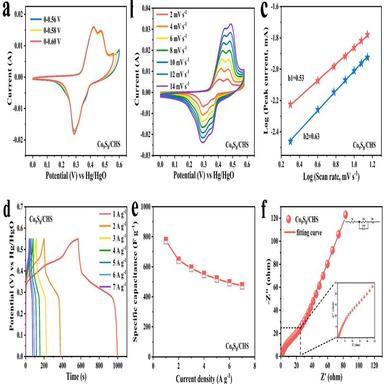
Electrochemical properties of Co9S8/CHS in a positive voltage window: (a, b) CV curves; (c) Log(i) versus log(v) plots; (d) GCD curves; (e) the specific capacitance of Co9S8/CHS and (f) Nyquist diagram.